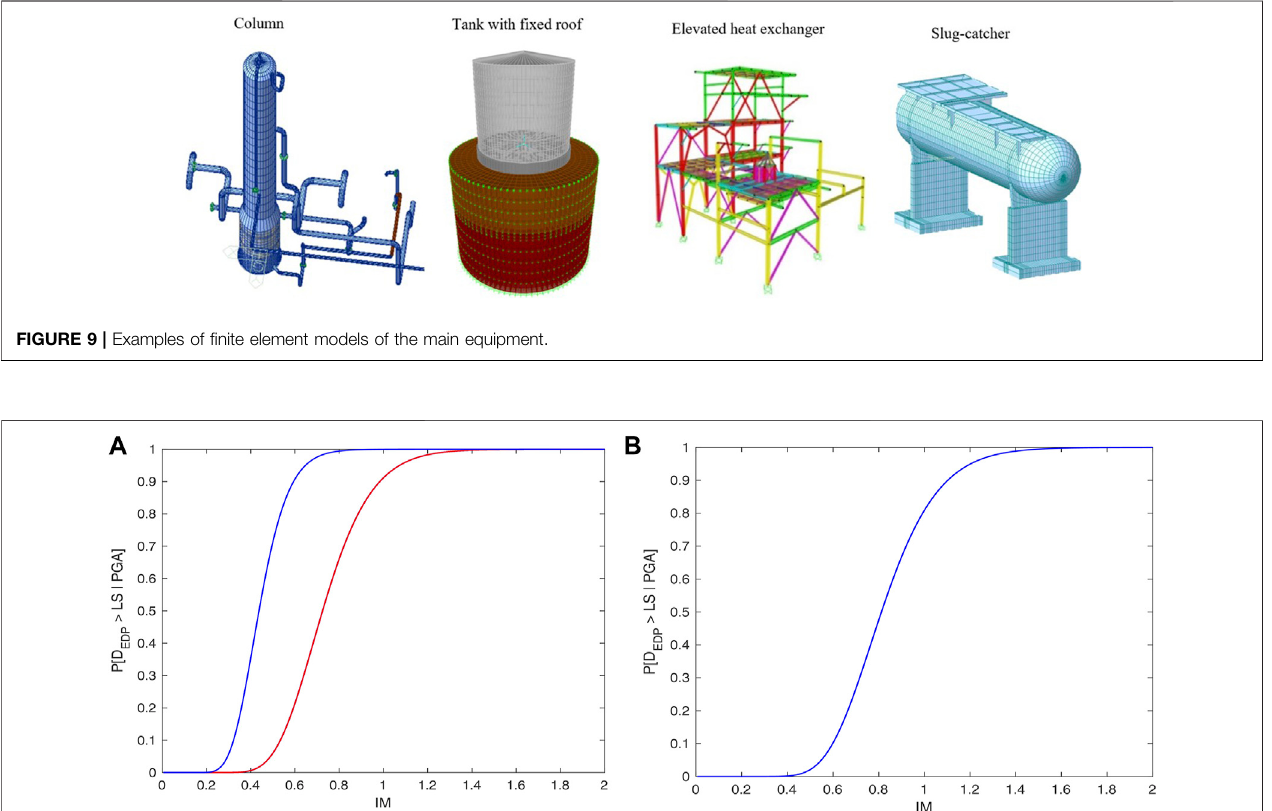
Frontiers in Built Environment |